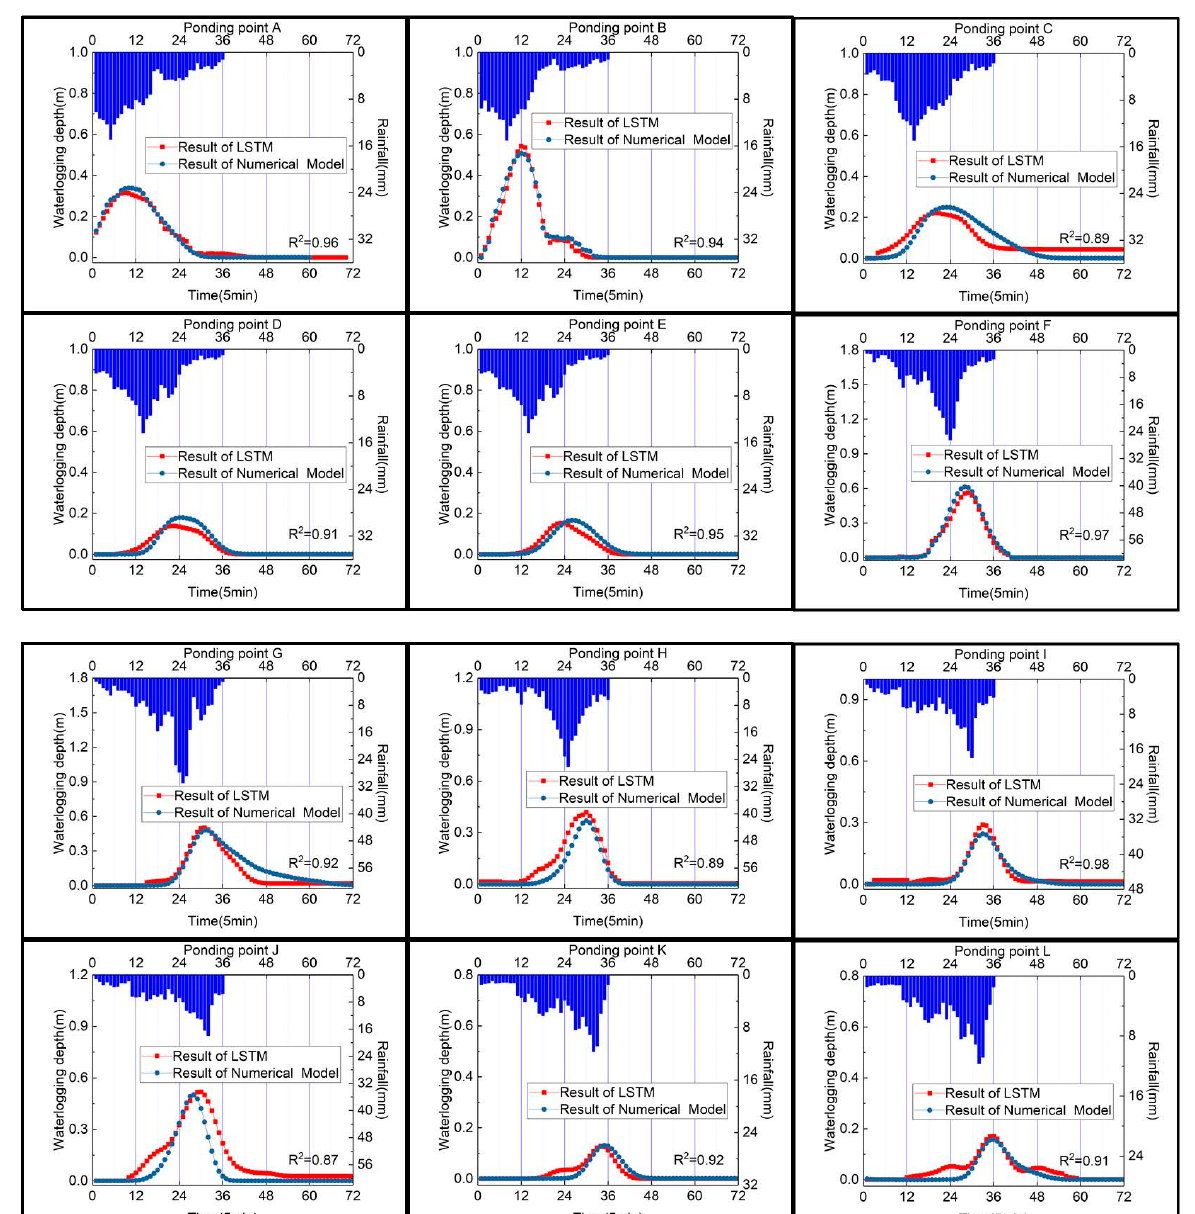
Figure 12. Simulation results of rainfall schemes moving from west to east.